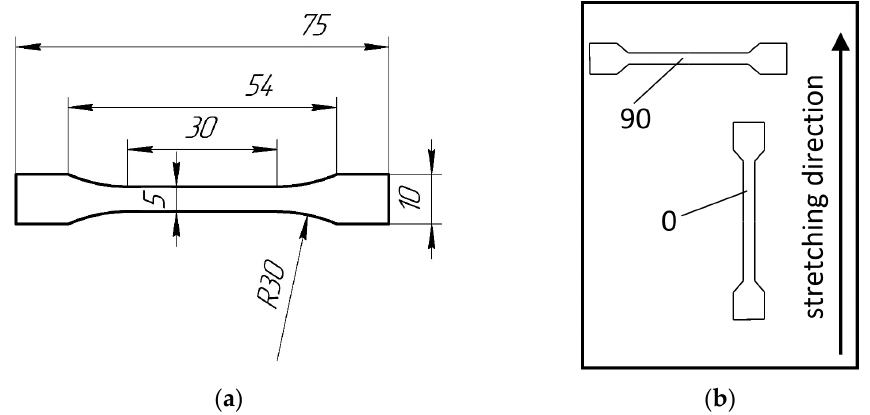
Figure 1. Dimensions of the film samples tested in tension ( a ) and the scheme of their cutting from the fi lm ( b ).